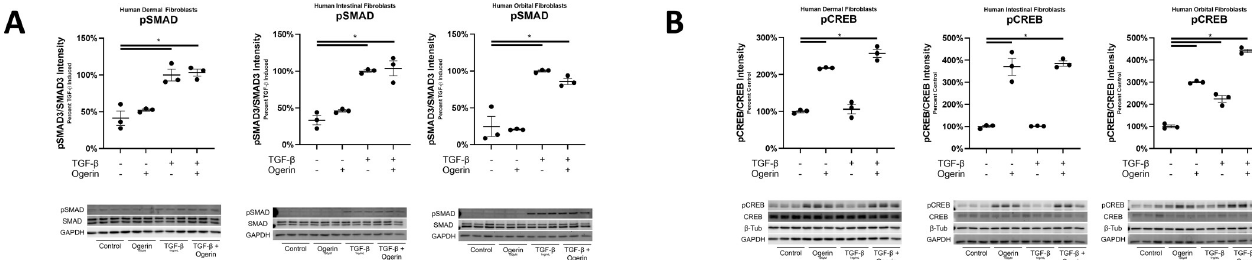
Fig 9. Ogerin does not inhibit TGF- β induced SMAD3 phosphorylation, and induces G α s signaling in human dermal, intestinal, and orbital fibroblasts. A,B: Human Dermal, Intestinal, and Orbital fibroblasts were co-treated with TGF- β (5ng/mL Dermal, 1ng/mL Intestinal and Orbital) and/or 150 μ M Ogerin for 40 minutes. Whole cell lysates were analyzed for phosphorylated SMAD3 expression via Western Blot. Phosphorylated SMAD3 band intensity was standardized to total SMAD3 band intensity and expressed as a percent of TGF- β induced. Whole cell lysates were analyzed for phosphorylated CREB expression via Western Blot. Phosphorylated CREB intensity was standardized to total CREB expressed as a percent of control. � = p < 0.05, by One -Way ANOVA with Tukey’s Post-Hoc Test for Multiple Comparisons.